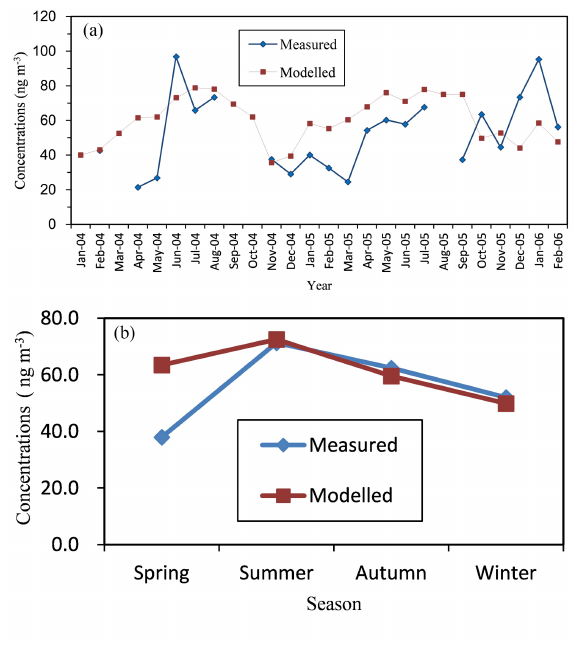
Figure 3. (a) Comparison of calculated (red) and measured (blue) monthly mean BC concentrations at the surface level during Jan- uary 2004 to February 2006 measured by the Cold and Arid Regions Environmental and Engineering Institute, Chinese Academy of Sci- ences. (b) Comparison of calculated (red) and measured (blue) sea- sonal variations during January 2004 to February 2006. Spring in- cludes March, April and May in 2004 and 2005. Summer includes June, July and August in 2004 and 2005; autumn includes Septem- ber, October and November in 2004 and 2005; winter includes De- cember, January and February of 2004 and 2005 and January and February in